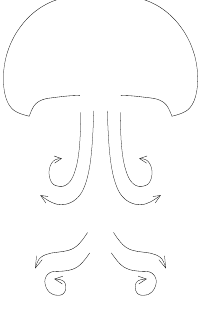
Figure 3. Schematic representation of non-swimming locomotion.